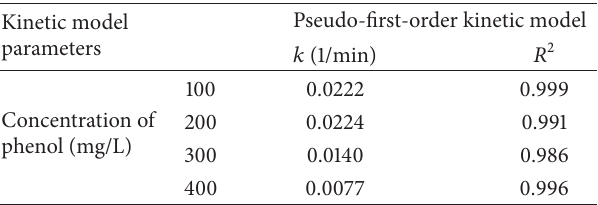
Table 1: Kinetic parameters for different initial concentration of